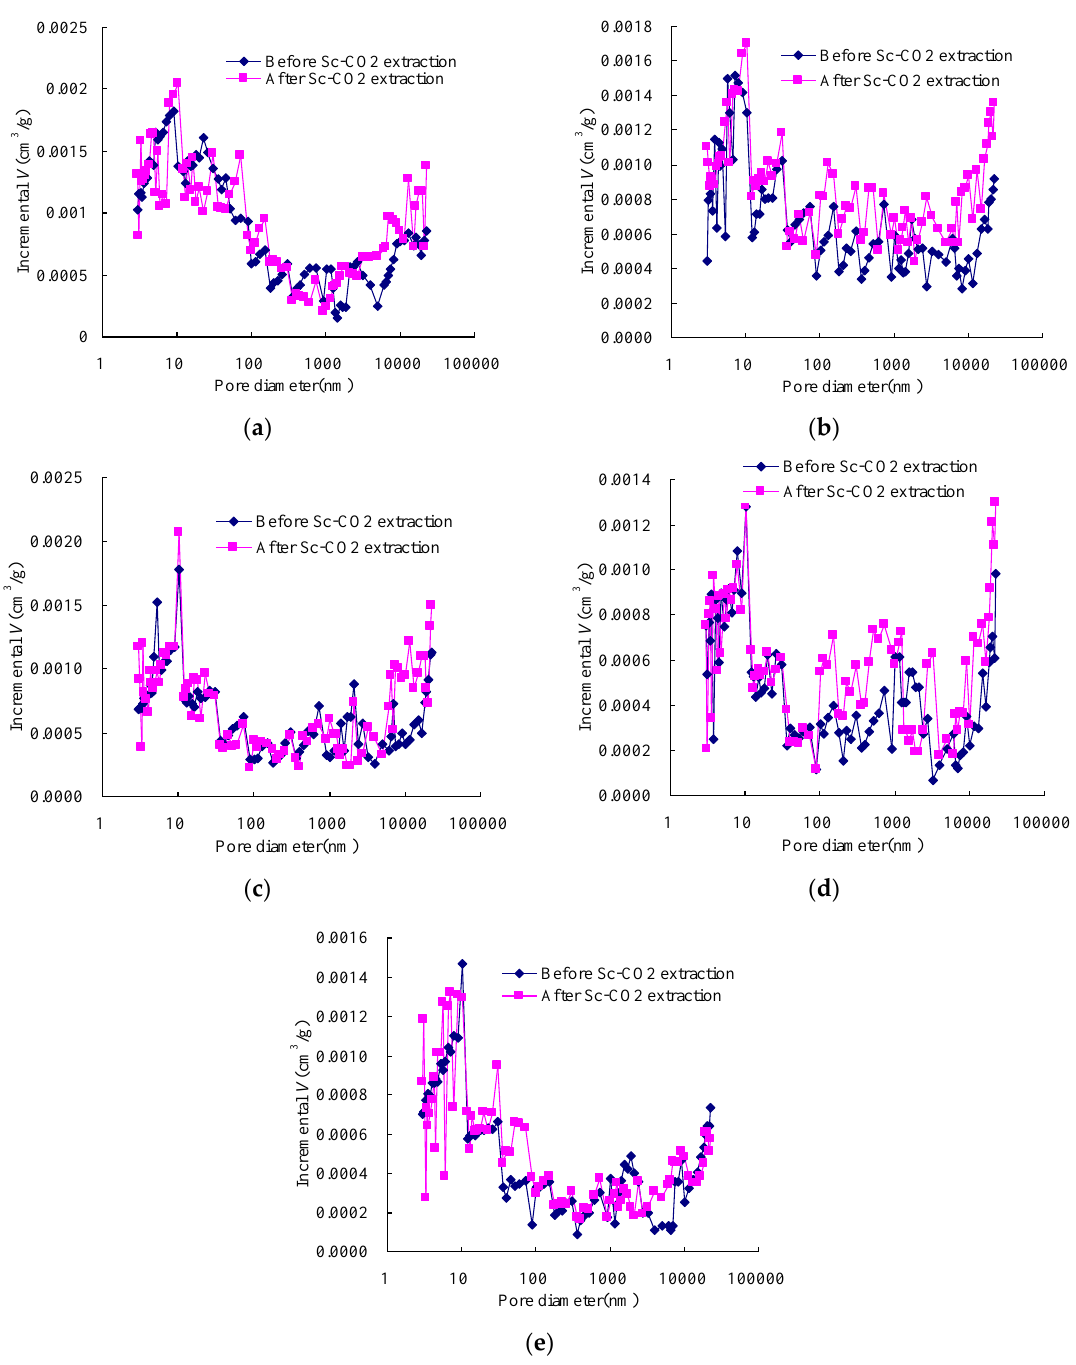
Figure 3. Pore distribution of the coals before and after Sc-CO 2 extraction: ( a ) Qiyi coal; ( b ) Liulin coal; ( c ) Dengjiazhuang coal; ( d ) Shuangliu coal; ( e ) Maozequ coal.